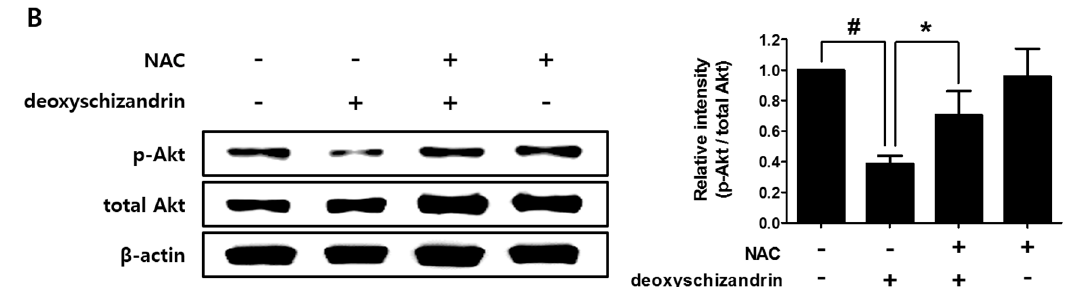
Figure 5. Involvement of Akt signalling in deoxyschizandrin-induced cell cycle arrest in A2780 cells: ( A ) A2780 cells were transfected with Akt expression vector and were treated with deoxyschizandrin (30 µM) for 48 h. MTT assay was performed to measure the cell viability in A2780 cells. The values represent the mean ± SD of results from three independent experiments. # p < 0.05 vs. the control group; * p < 0.05 vs. the treated group transfected with empty vector; ( B ) A2780 cells were treated with 5 mM of N -acetyl- L -cystein (NAC) and deoxyschizandrin (30 µM) for 8 h. Western blot analysis was performed to measure the phosphorylation of Akt in A2780 cells. β -Actin was used as an internal control. Band images are representatives of three individual experiments and the results of densitometry represent the mean ± SD of three independent experiments. # p < 0.05 vs. the control group; * p < 0.05 vs. the treated group.